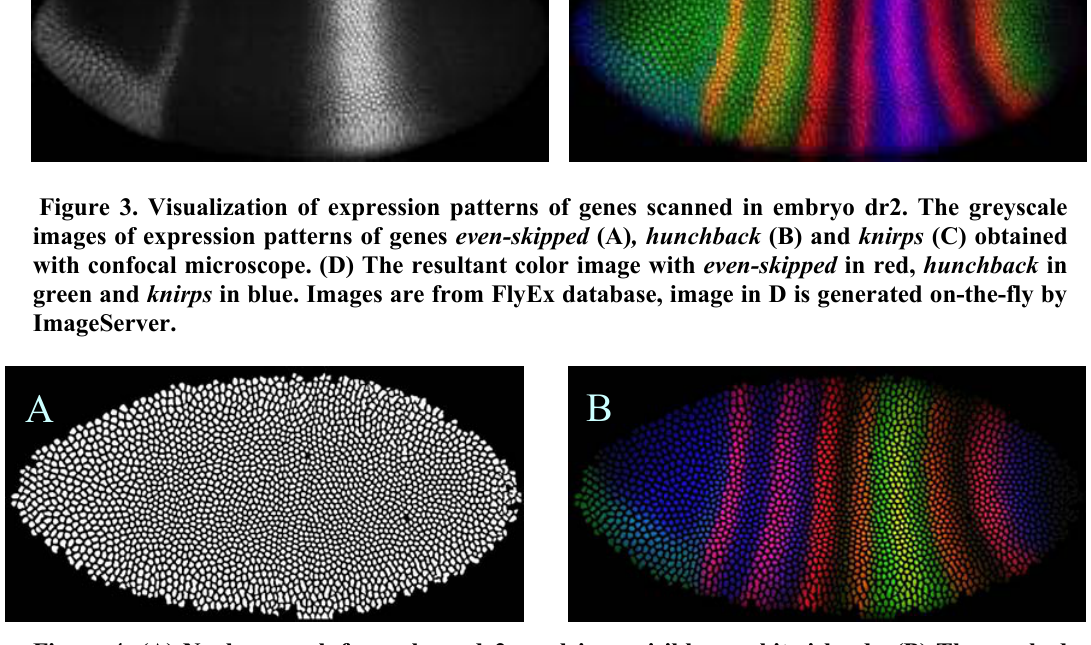
Figure 4: (A) Nuclear mask for embryo dr2, nuclei are visible as white islands. (B) The masked image obtained by superposition of this mask on the image shown in Figure 3D. Here only those pixels are colored that belong to the nuclear mask and are white in Figure 4A.